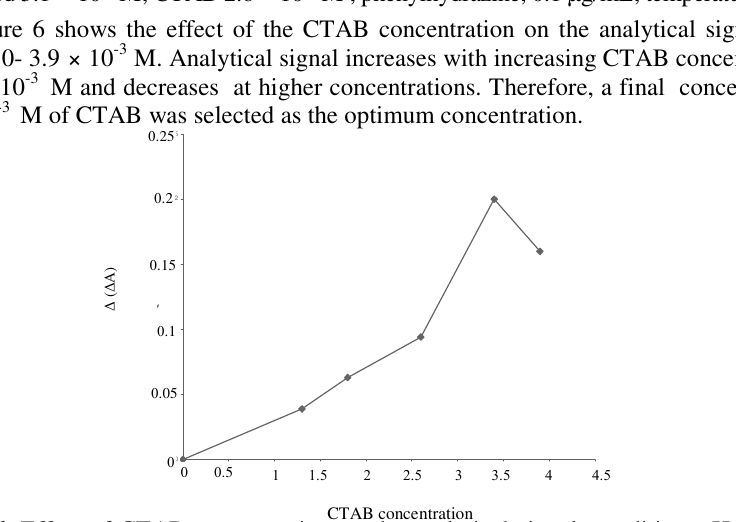
Figure 5. Effect of Bromate concentration on the analytical signal, conditions: HCl 0.06 M, methyl red 5.1 × 10 -5 M; CTAB 2.6 × 10 -3 M ; phenylhydrazine, 0.1 µ g/mL; temperature 27 °C